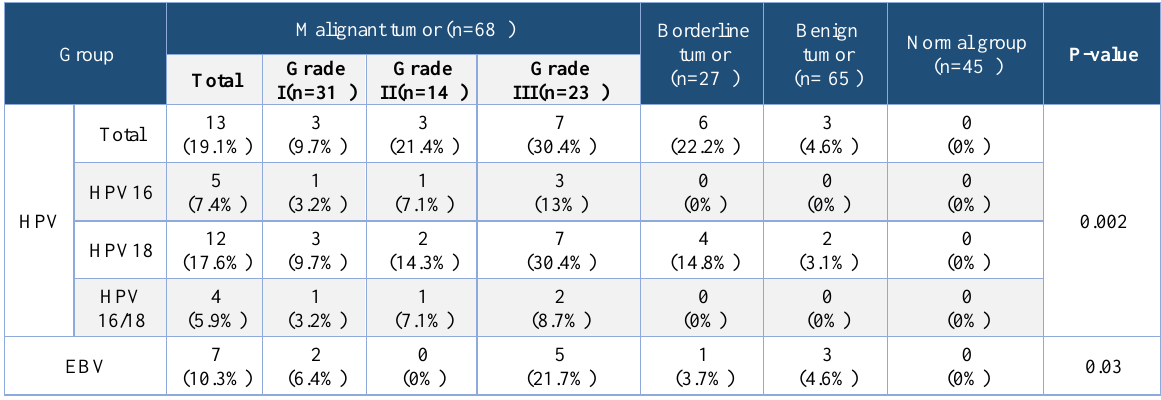
Table 3. The frequency of HPV and EBV in four study